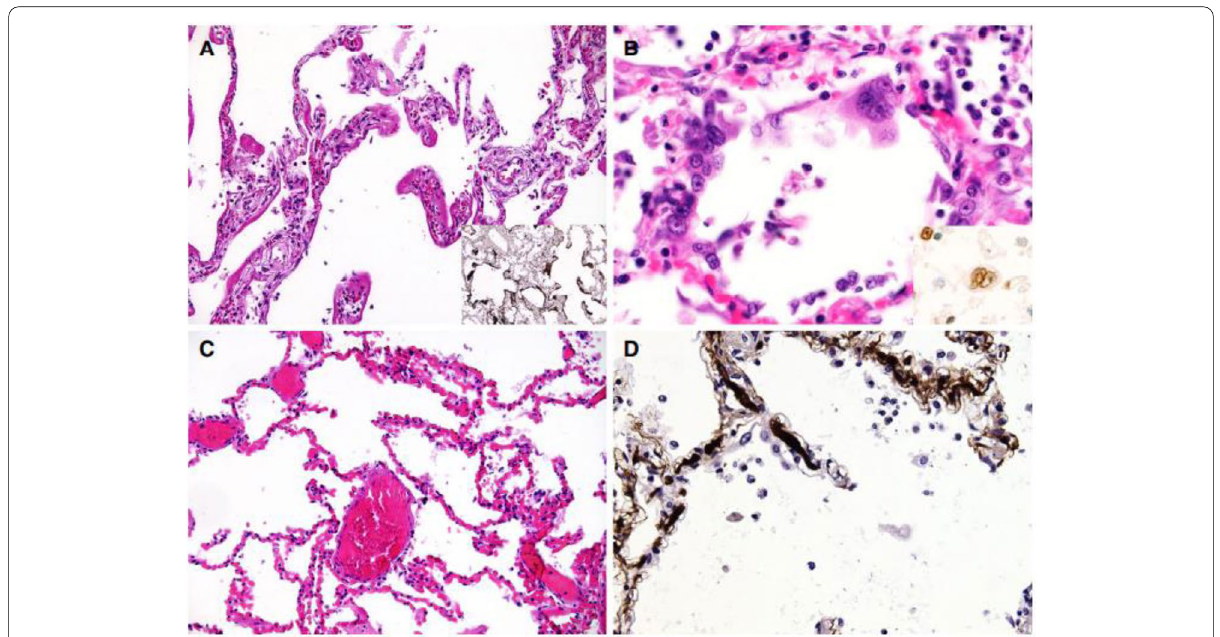
Fig. 3 Microscopic lung findings. A Exudative diffuse alveolar damage (DAD) showing discrete hyaline membranes and prominent capillary congestion [haematoxylin and eosin (H&E)]. Insert: immunohistochemistry (IHC) for fibrinogen showing the extent of hyaline membranes. B Syncytial cells of pneumocyte II origin (H&E). Insert: IHC for thyroid transcription factor 1. C Extensive capillary congestion without DAD (H&E). D Microthrombi in alveolar capillaries (IHC for fibrin). Note: Source of figure from Menter et al.